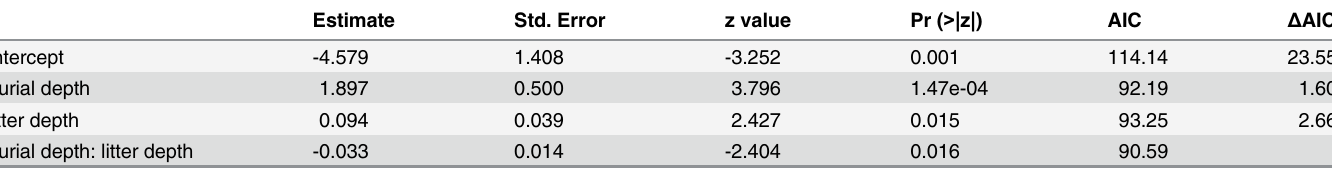
burial depth: litter